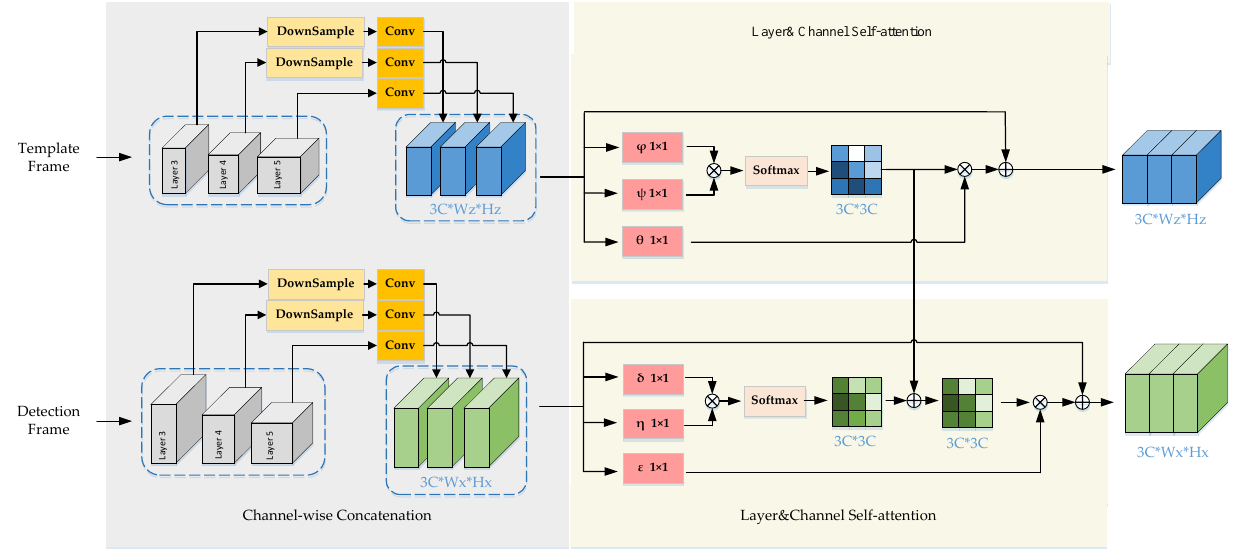
Figure 2. Schematic diagram of the proposed DBA block. The module consists of two parts: Channel-wise Concatenation and Layer-Channel Self-attention.